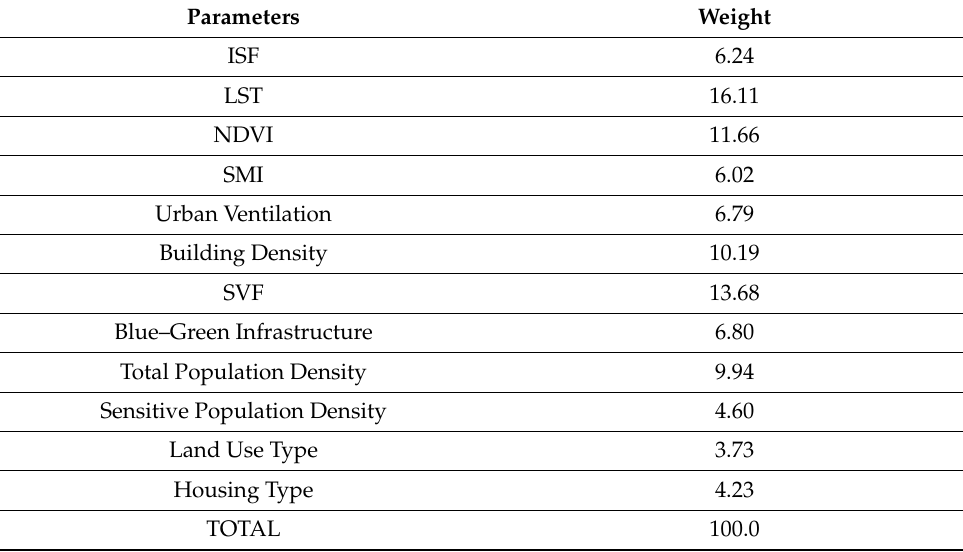
Table 6. Weights of parameters calculated using AHP